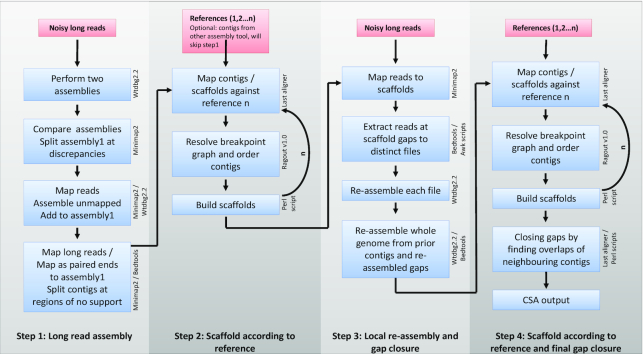
Flow chart of the 4-step CSA pipeline.